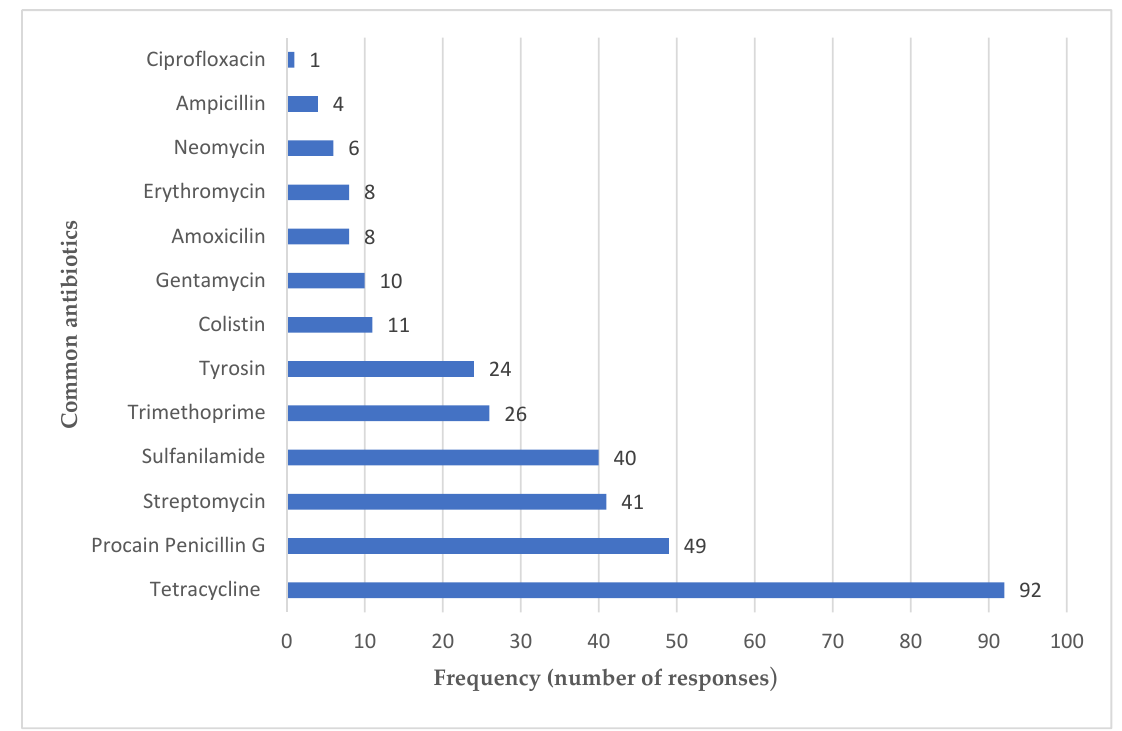
Figure 1. Distribution of commonly dispensed antibiotics by agrovet shops.